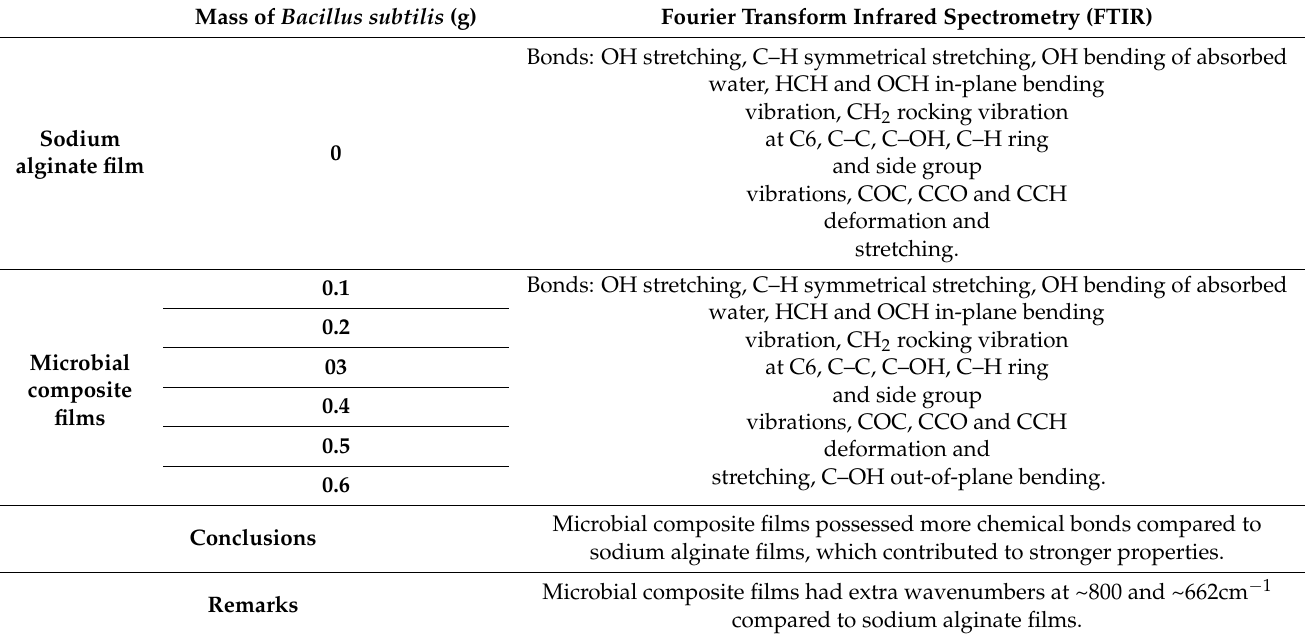
Table 4. Conductivity and Fourier transform infrared spectrometry (FTIR) of sodium alginate film and microbial compos- ite